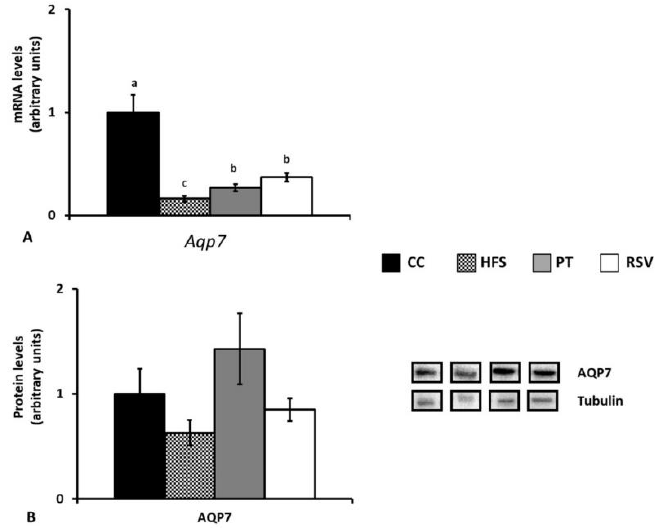
Figure 7. Interscapular brown adipose tissue gene ( A ) and protein ( B ) expressions. Different letters indicate statistically significant differences. Aqp7 and AQP7: aquaglyceroporin 7.